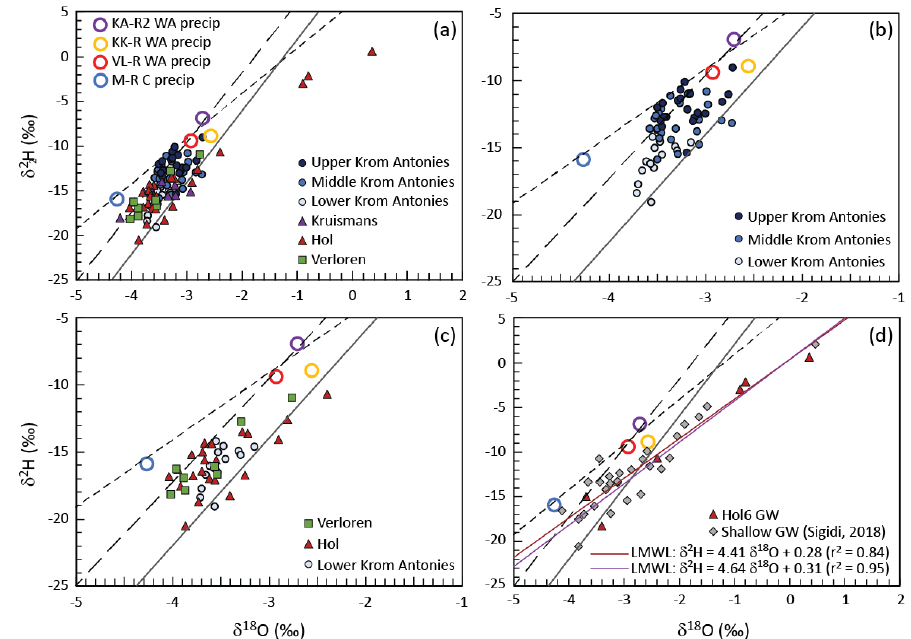
Figure 8. Stable isotope values of groundwater from the Verlorenvlei catchment. ( a ) Groundwater from all four tributaries examined in this study as well as the weighted average of precipitation from the four precipitation collectors, ( b ) variation between the upper, middle and lower Krom Antonies, ( c ) comparison between the Hol and lower Krom Antonies groundwater, and ( d ) comparison between the groundwater from location Hol6 and shallow groundwater in the alluvial aquifer in the Hol and down to the confluence derived from [38]. LMWLs for 2015 and 2016 as per Figure 6. GMWL (solid grey line) derived from Craig (1961). WA = weighted average, precip = precipitation, GW =